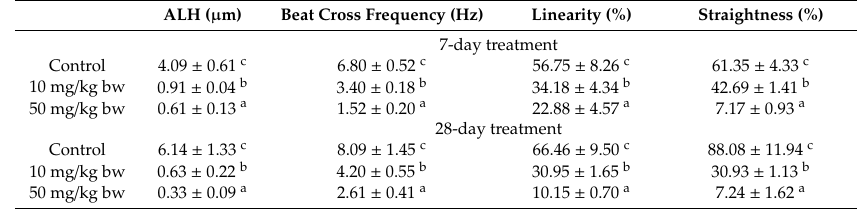
Table 7. E ff ects of sub-dermal administration of Ag-NP on sperm velocity parameters in male rats. ALH ( µ